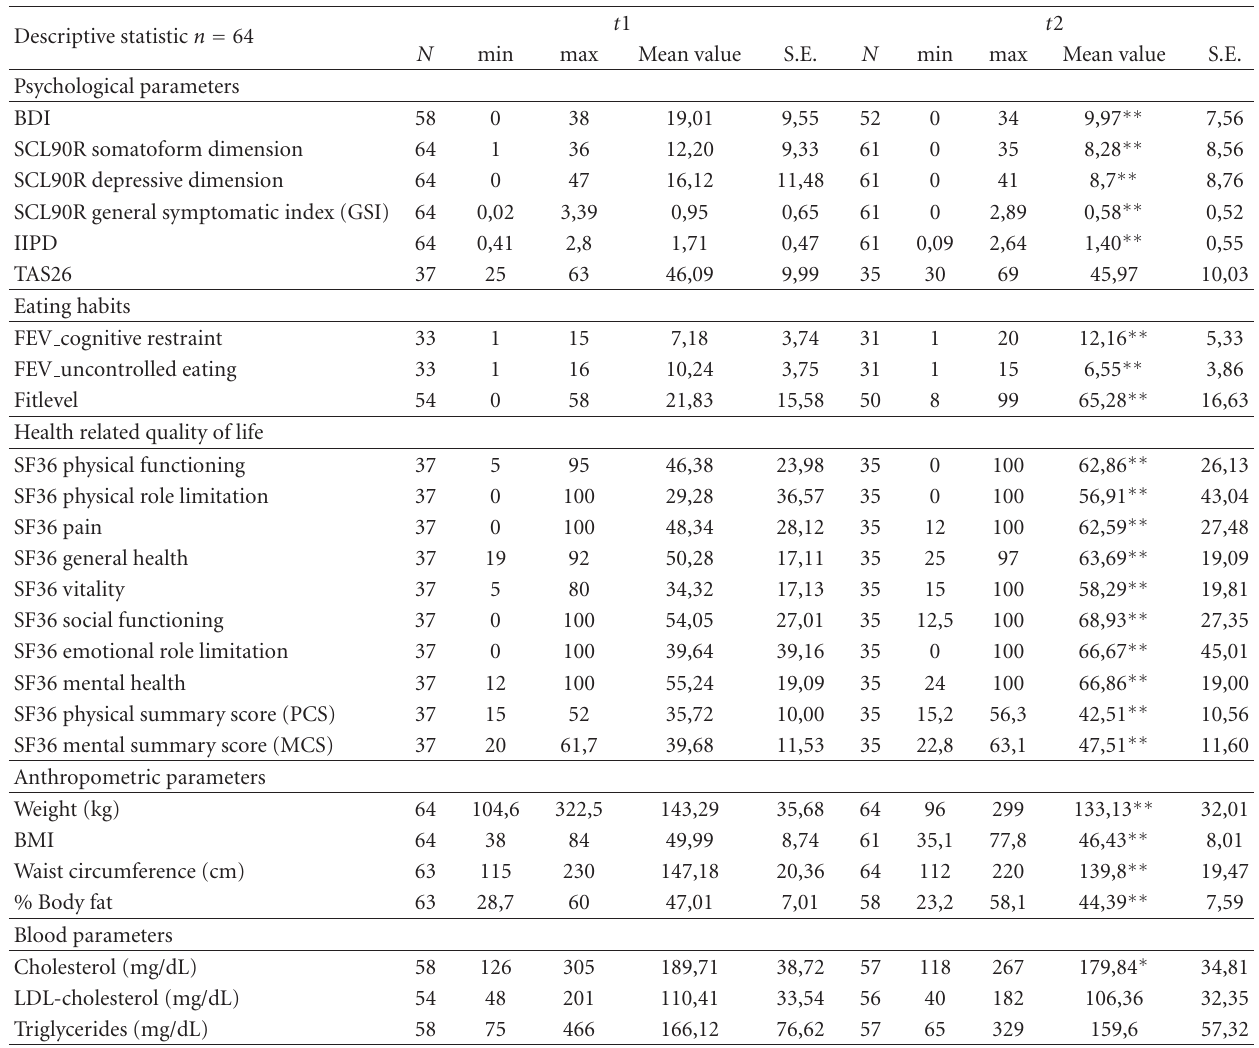
Table 5: Descriptive statistics of the subgroup BMI > 40kg/m 2